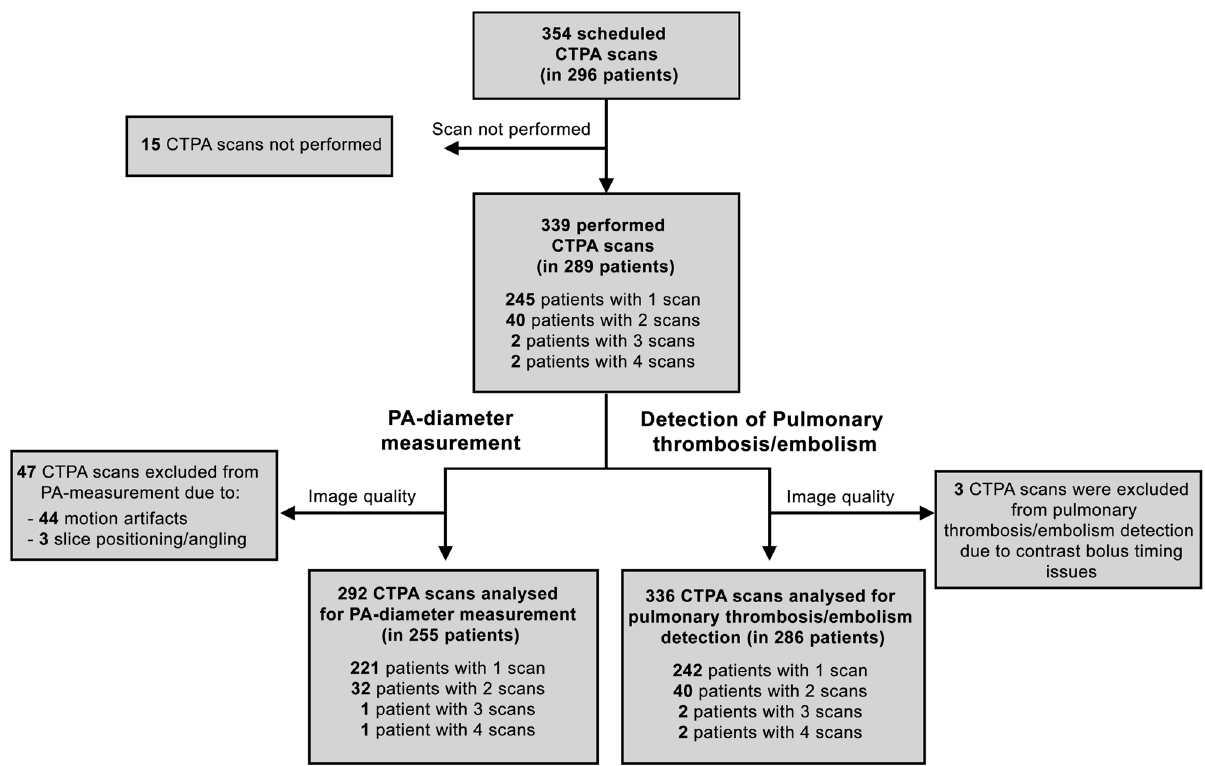
Fig. 1 Flowchart of the CTPA cohort and subsequent analyses. CT: computed tomography; CTPA: computed tomography pulmonary angiography; PA: pulmonary artery.